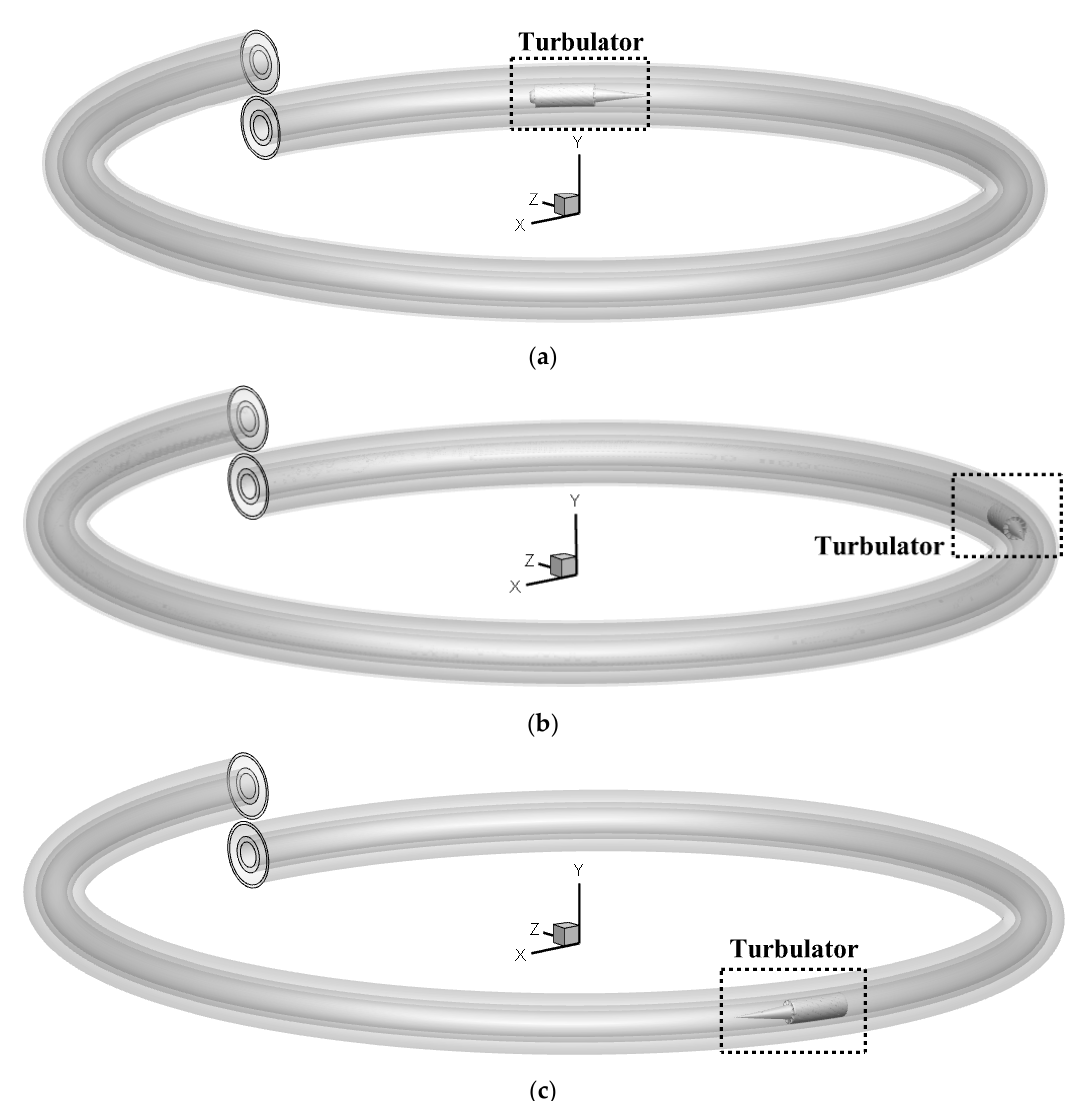
Figure 4. The graphics of the swirl generators with various positions at n = 12, θ = 180 degrees, and L 1 = 100 mm; ( a ) S = 0.1 π mm, ( b ) S = 0.3 π mm, and ( c ) S = 0.5 π mm. L π mm, ( b ) S = 0.3 π mm, and ( c ) S = 0.5 π 1 = 100 mm; ( a ) S = 0.1